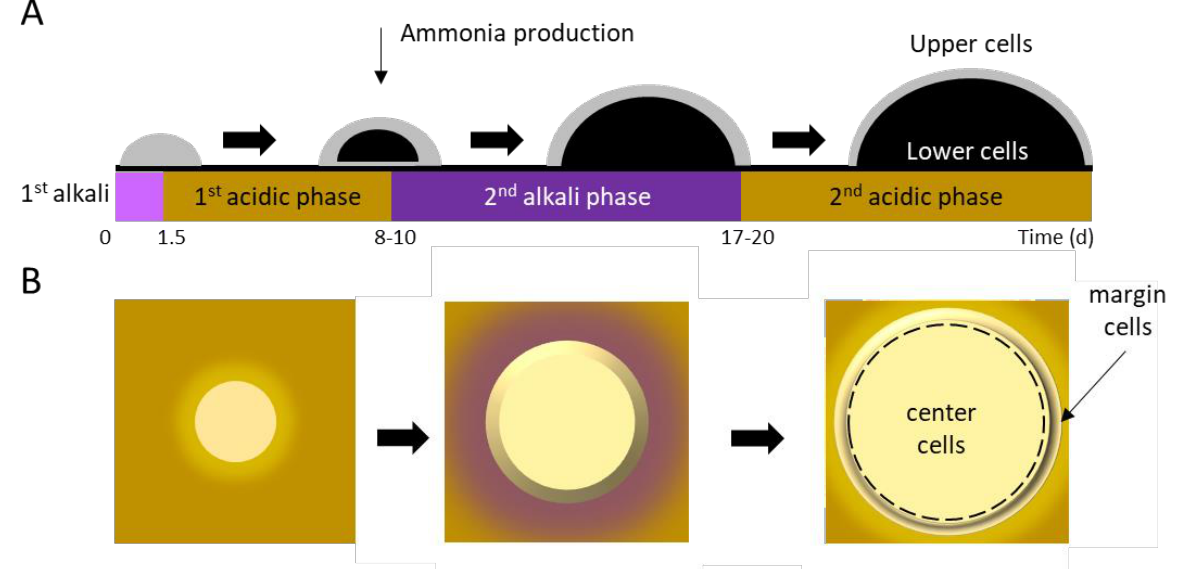
FIGURE 2: Yeast colonies transition through alkali (pH ~6.8) and acidic (pH ~5.2) phases, causing the area around a colony to change in color from yellow to purple and back again on agar containing Bromocresol purple. The pH changes contribute to cellular differentiation in both the vertical (A) and horizontal (B) dimensions. Gray indicates healthy, dividing cells and black indicates non-dividing